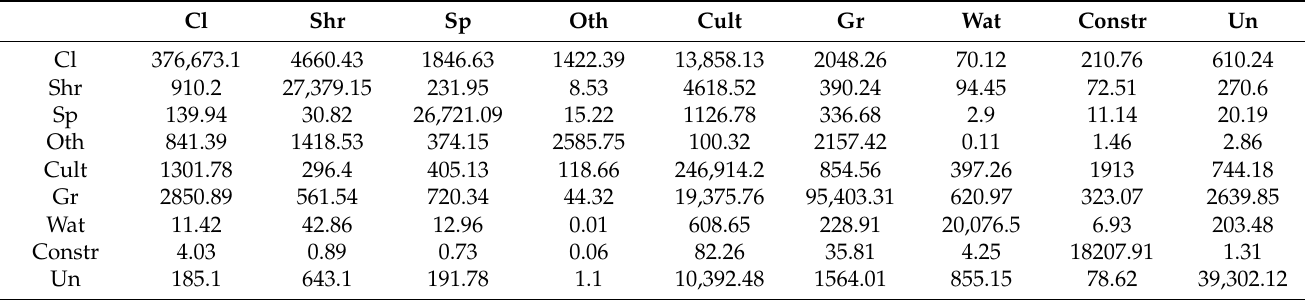
Table 6. Conversion of Land Types from 1980 to 2000 (km 2 ).